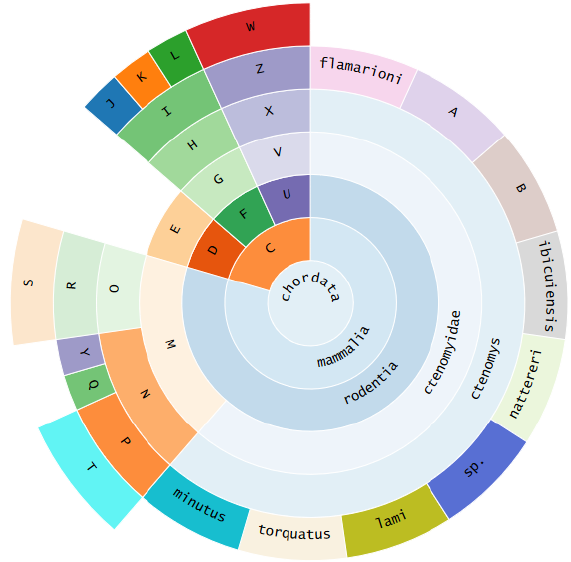
Figure 5. Sunburst visualization with taxa inserted to demonstrate how the visualization will look like when the database is properly populated. Nodes labeled ’C’, ’N’, ’minutus’, ’lami’ and ’sp’ have been